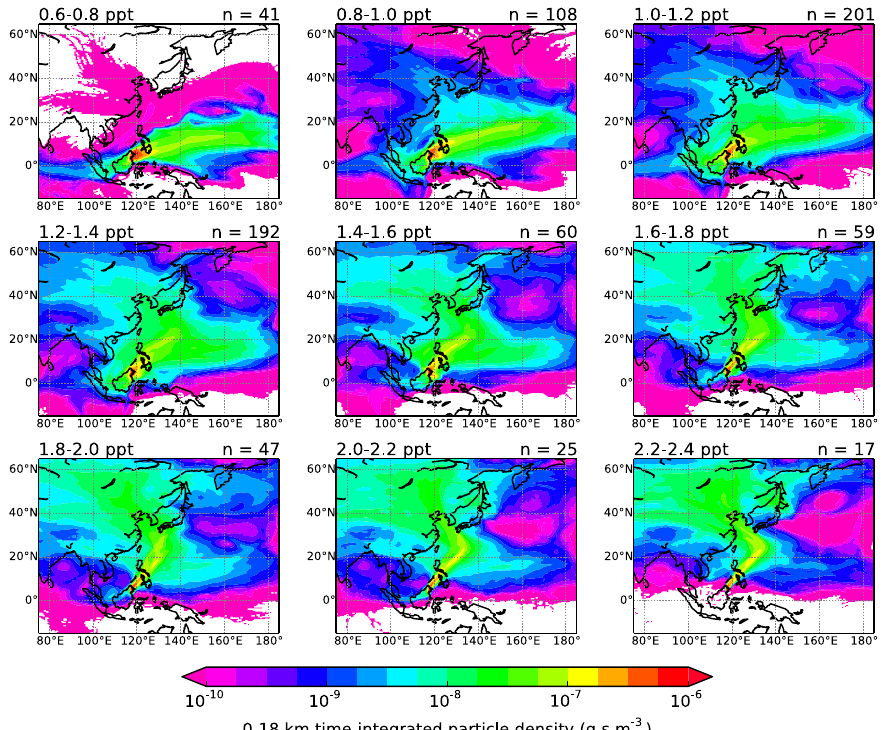
Figure 2. Composite air history maps for each C 2 Cl 4 mixing ratio interval of 0.2ppt at Tawau. The number of 3h periods, n , contributing to each composite is noted above each panel. A mixing ratio greater than 2.4ppt was observed in eleven 3h windows; these periods are not accounted for in the